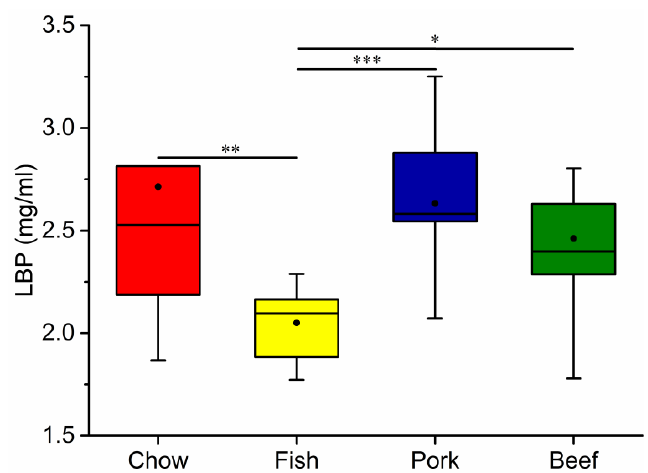
Figure 4. Changes in serum lipopolysaccharide-binding protein (LBP) levels of mice fed laboratory chow, fish, pork, or beef. The numbers of mice in each group were: chow, 10; fish, 10; pork, 10; and beef, 9. Whiskers in the boxplot represent the range of minimum and maximum alpha diversity values within a diet group. The black dot in the boxplot is the mean. The horizontal line in the boxplot is the median. * p < 0.05, ** p < 0.01, *** p < 0.001. Microorganisms 2019 , 7 , x